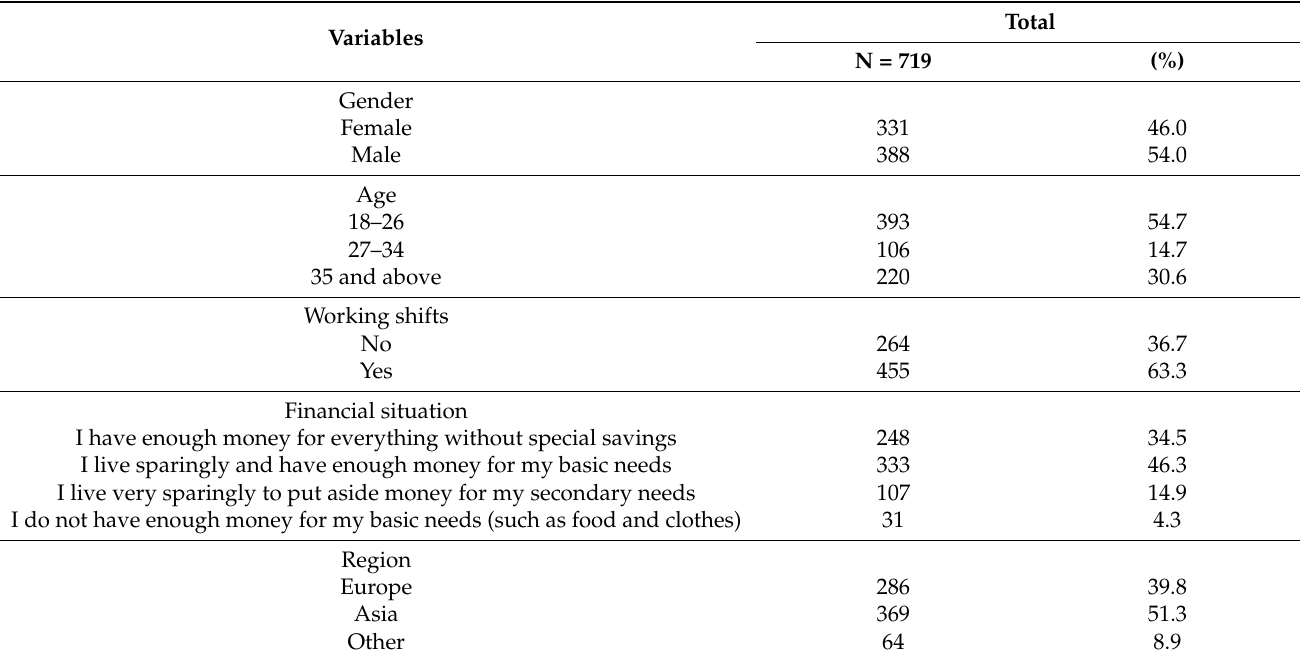
Table 1. Characteristics of the studied group, considering selected socio-demographic